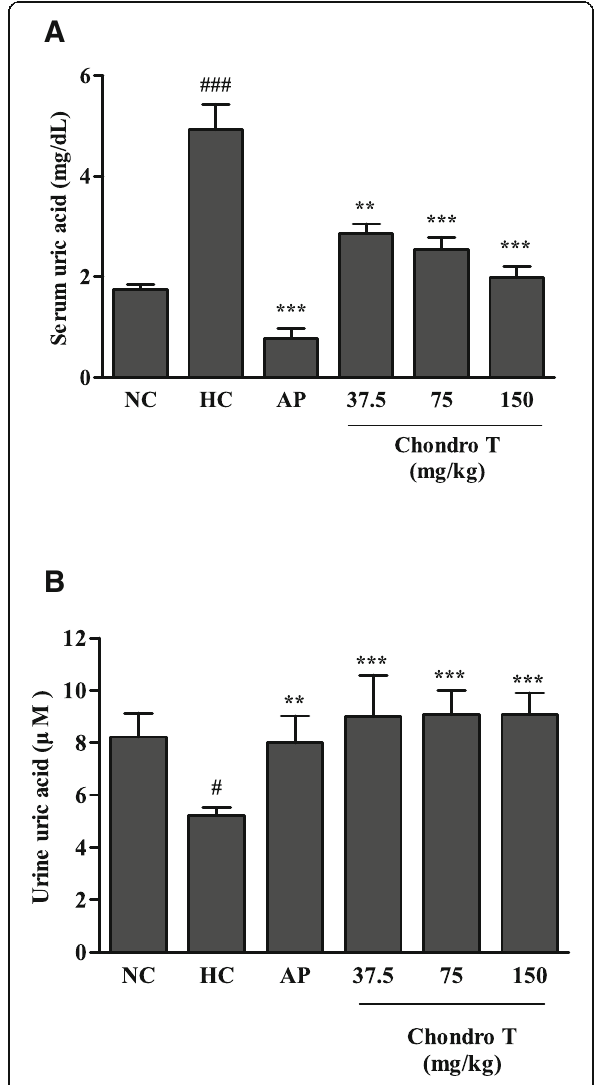
Fig. 1 Effects of ChondroT on uric acid in ( a ) serum and ( b ) urine of potassium oxonate (PO)-induced hyperuricemic mice NC, normal control; HC, hyperuricemic control with potassium oxonate (300 mg/kg); AP, allopurinol (5mg/kg). Values are expressed as the mean± standard error (S.E., n =5). # P <0.05 and ### P <0.001 compared with NC group; ** P <0.01, and *** P <0.001 compared with HC